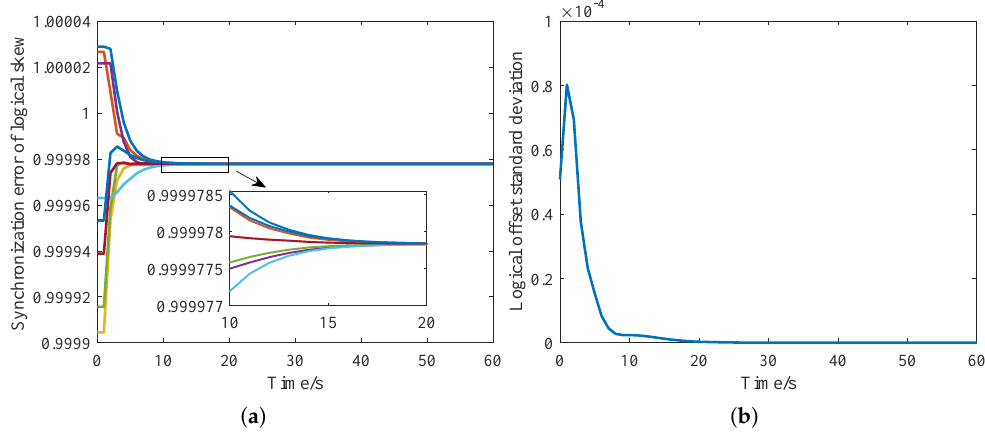
Figure 2. The convergence of the logical clock in the mesh layer. ( a ) Logical clock skew; ( b ) Logical clock